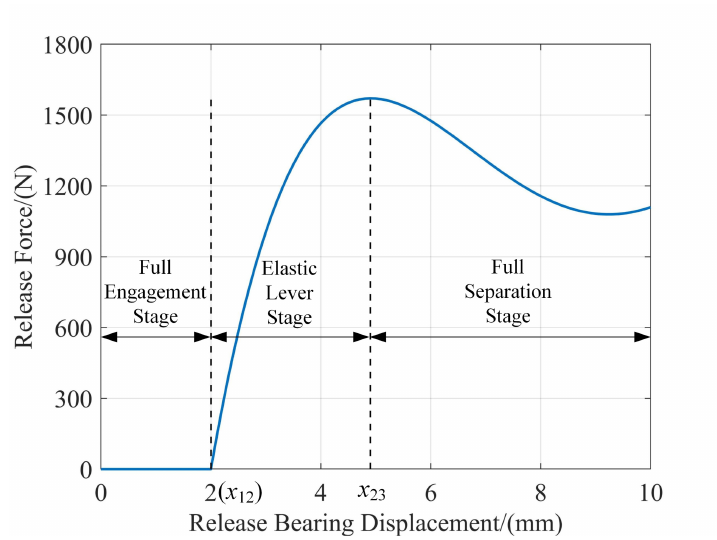
Figure 7. Separation characteristic curve of the clutch.